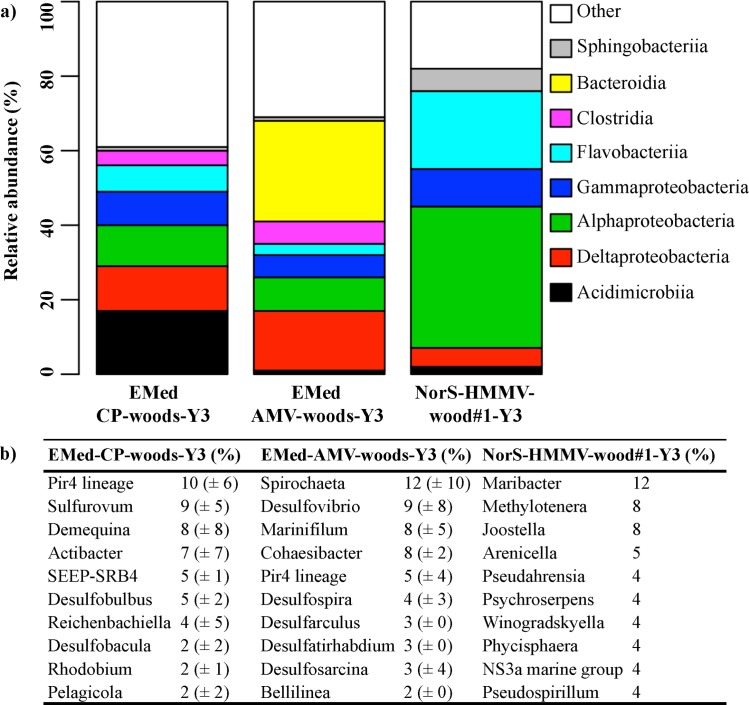
Taxonomical comparison of bacterial communities at the class (a) and genus (b) level. Analysis reveal spatial variations in the wood-associated bacterial communities immersed for 3 years between experiments at the Central Province (CP), Amon Mud Volcano (Amon) and Håkon Mosby Mud Volcano (HMMV). (a) Depicts the five and (b) the ten most sequence-abundant classes and genera, respectively, given as percentages. For this analysis sample of wood experiments deployed in the same province were pooled together. See also S6 Table for more details.